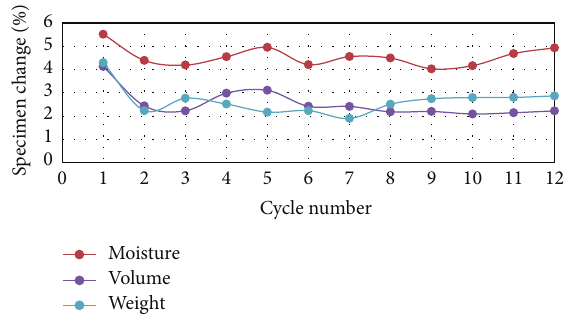
Figure 9: Moisture, volume, and weight changes of BETB.